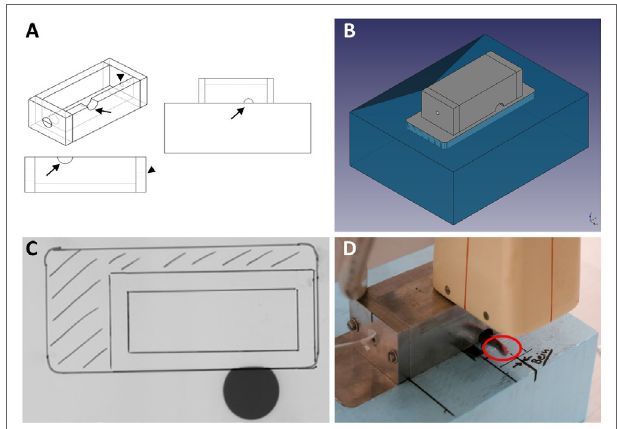
FigUre 4 | Establishment of a local in vivo irradiation procedure for hind limbs of h TNF- α tg mice. The applicator (a) is built from 10 mm lead pieces in order to shield the mouse from irradiation. Only the left hind leg can be pulled through an opening (indicated by arrows). Another opening (indicated by arrowheads) allows for a tube, releasing anesthetics into the chamber, to be inserted. This ensures that the mice stay into place during the whole procedure. The whole set-up then gets placed onto a 10 mm lead plate that is embedded into an 80 mm Styrodur ® block (B) . The embedded lead plate guarantees that the mouse is completely protected from X-rays and only the exposed limbs receive the intended dose of 0.5 Gy. Image (c) shows proof-of-concept on radiographic film: the gray circle indicates that only the exposed limb is receiving a dosage. The body of the mouse is efficiently shielded from X-rays by the lead applicator. The placement of the applicator and the embedded lead plate are indicated by markings on the film. Figure (D) shows a representative image of an irradiation procedure: the paw of the mouse is aligned according to pre-made markings on the Styrodur ® block, allowing for a precise and reproducible local irradiation of only the exposed extremities. Irradiation is applied through an X-ray tube equipped with